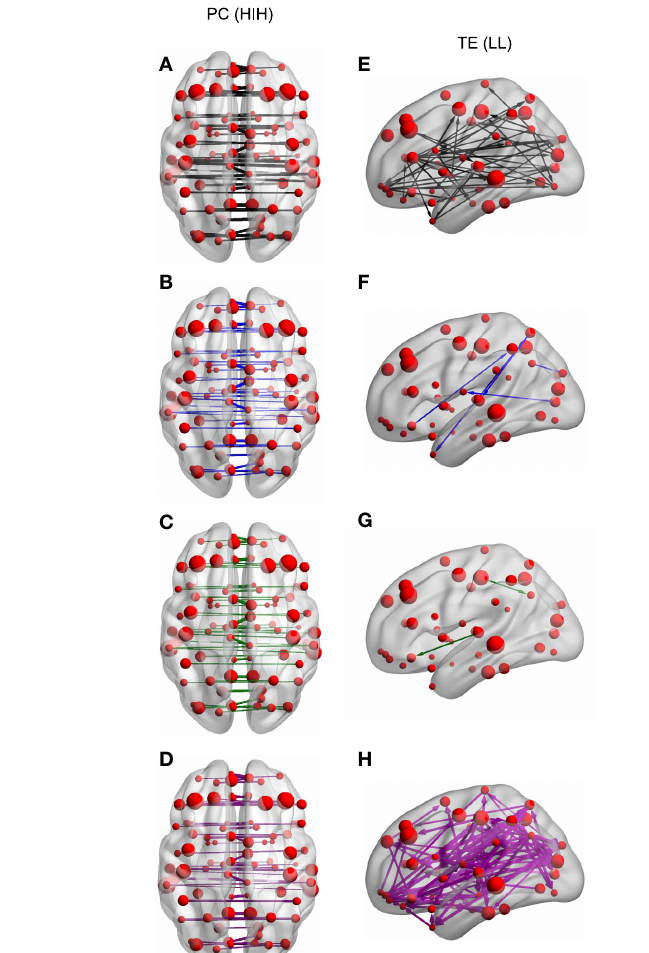
values bigger than TE = 0 . 2 are depicted. (I–K) Correlation between PC (solid line) and TE (dashed) with the CRS-R scores at the different functional scales: Auditory, Visual,Motor, Oromotor/Verbal, Communication, Arousal and the total sum over all the function scales (JFK) as well as with the acquisition time after trauma. The correlation has been calculated over pairs which are (I) inter-hemispheric (HIH for PC and (HLR+HRL)/2 for TE, (J) left intra-hemispheric (LL) and (K) right intra-hemispheric